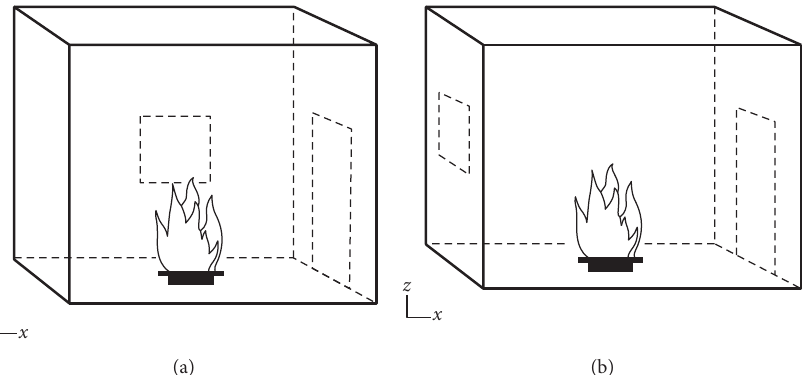
Figure 3: (a) Presentation of the domain under the PFC configuration. (b) Presentation of the domain under the PFO configuration.